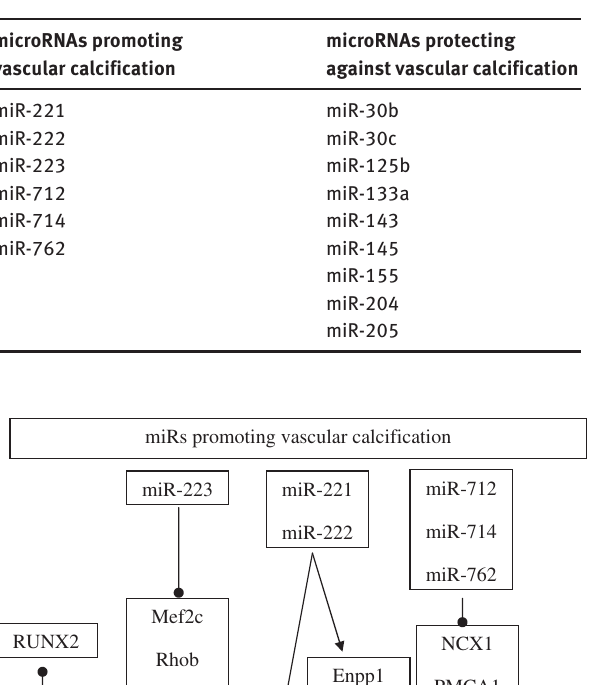
Table 1: Major microRNAs (miRs) involved in the pathogenesis of vascular calcification.